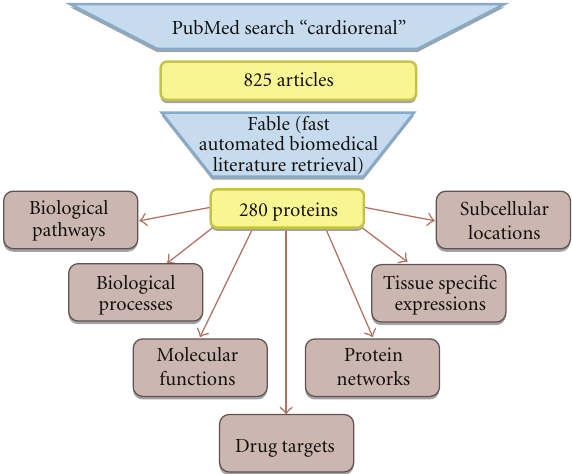
Figure 1: Overview scheme on the analysis workflow: Literature mining was applied for identifying unique proteins associated with CRS. Bioinformatics included feature characterization as well as network